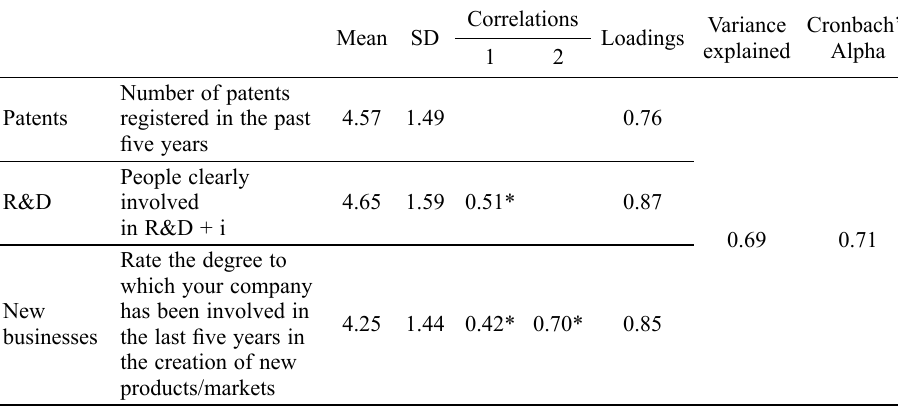
Table 2. Measurement of radical innovation